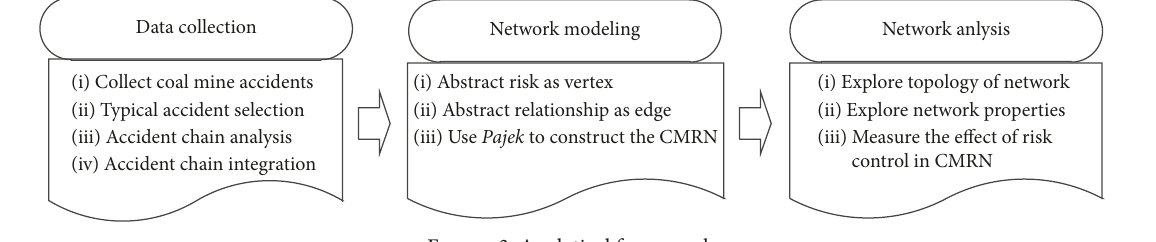
Figure 3: Analytical framework. Table 2: Two examples of the stored